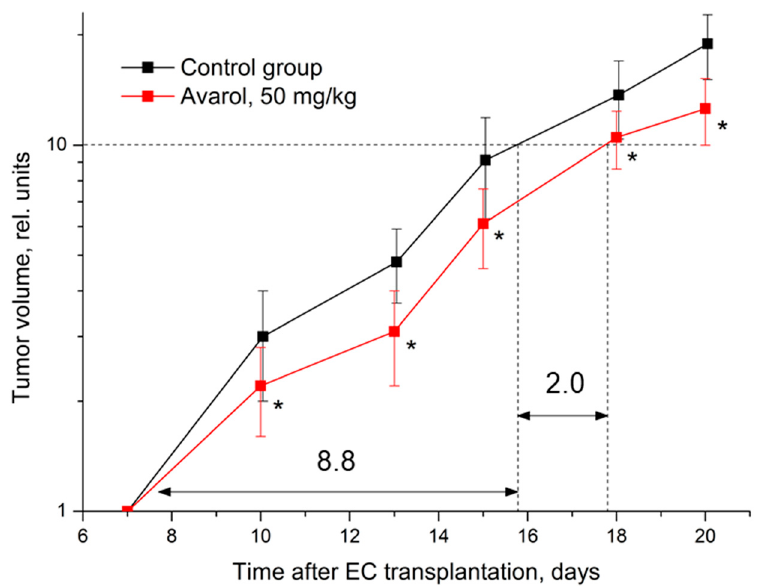
Figure 2. Influence of avarol on the dynamics of EC growth. Graphic deviations correspond to SD. *—statistically significant difference in tumor volumes compared to control. Dotted lines—assessment of the duration of growth retardation (days) in the time of a 10-fold increase in tumor volume. The arrows (and the numbers next to them) indicate a graphical estimate of the 10-fold increase in the volume of the tumor node.